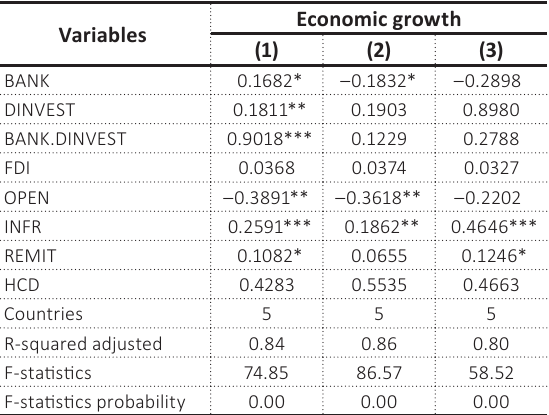
Table 3. Fixed effects results